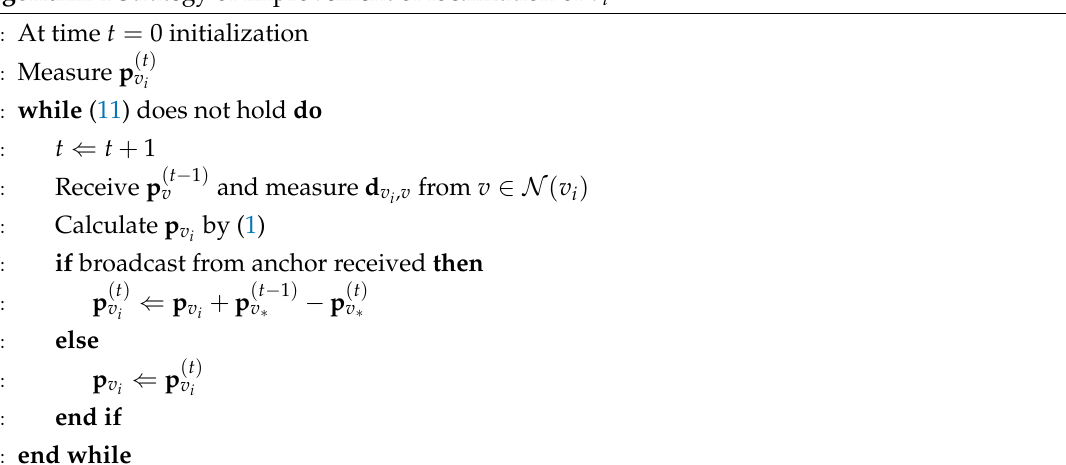
Algorithm 1 Strategy of improvement of localization of v